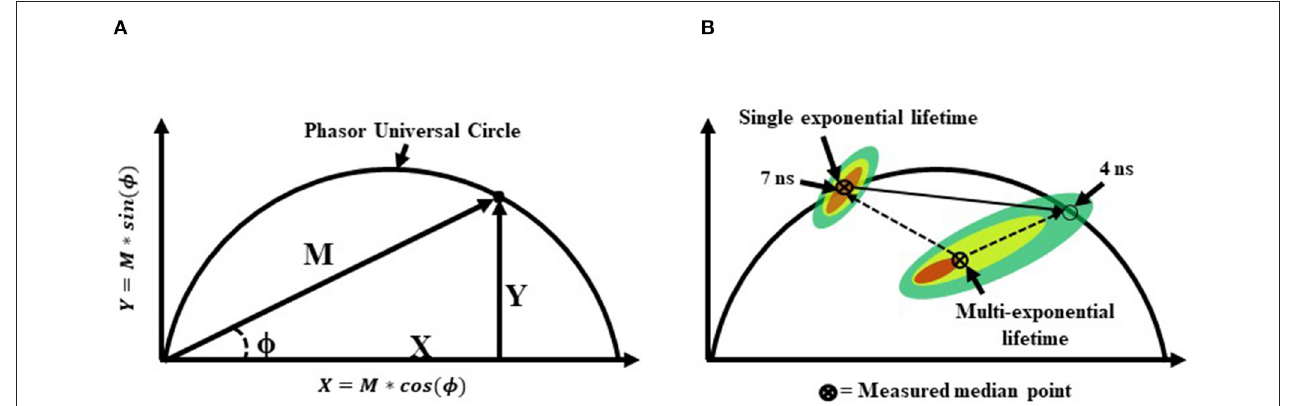
FIGURE 7 | (A) A graphical representation of a phasor graph. Raw data is transposed to the frequency domain by applying a discrete Fourier transform. Data are visualized in a frequency spectrum where the phase ( φ ) and modulation (M) factors are extrapolated to construct the phasor graphs. Calculated events that fall directly on the phasor universal circle represent a single exponential lifetime, whereas calculated events falling within the phasor universal circle represent multiple exponential lifetimes. Alternatively, it is possible to gain insight into the weighted mean lifetime by calculating fractional contributions of different lifetime components using lifetime component vectors as represented in part (B)